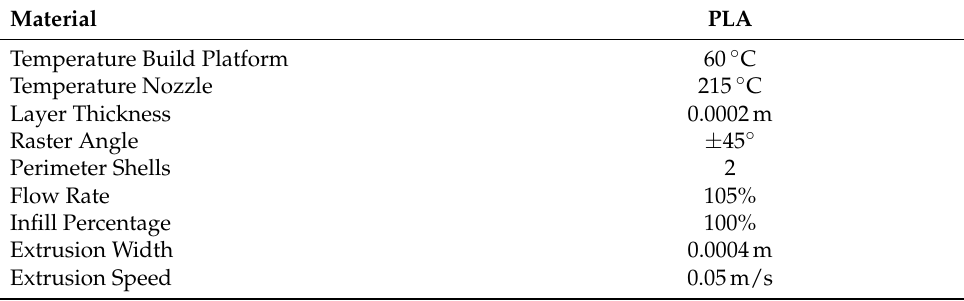
Table 1. Utilized process parameters for manufacturing of the test